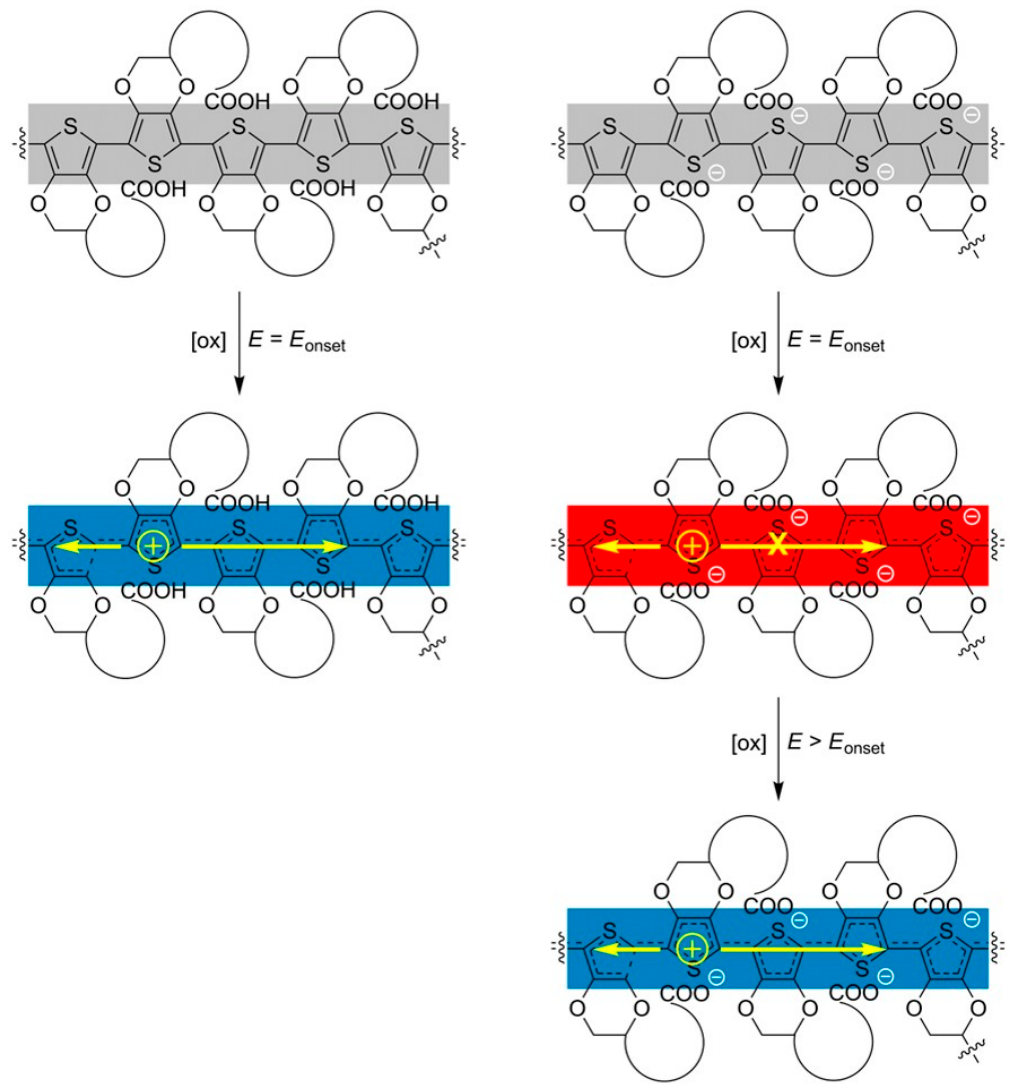
Scheme 2. Representation illustrated the side-chain deprotonation that perturbed the intrinsic conductivity of